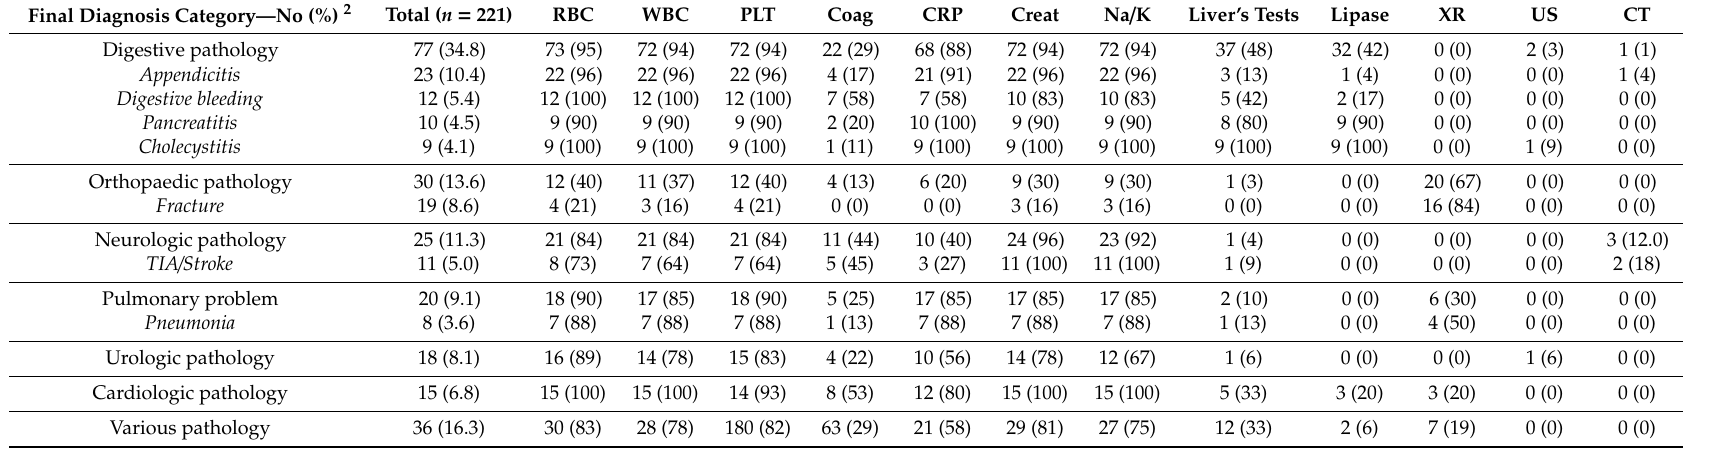
Table 3. Patients with partially or totally inappropriate redundant exams 1